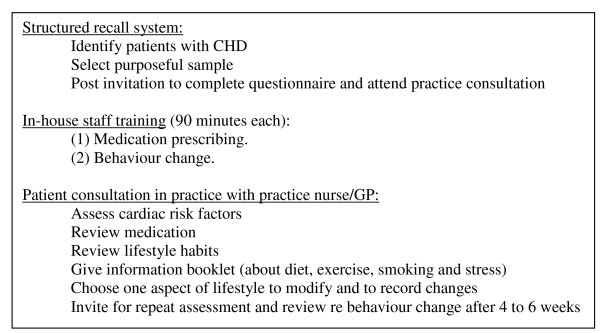
Exploratory pilot trial protocol.